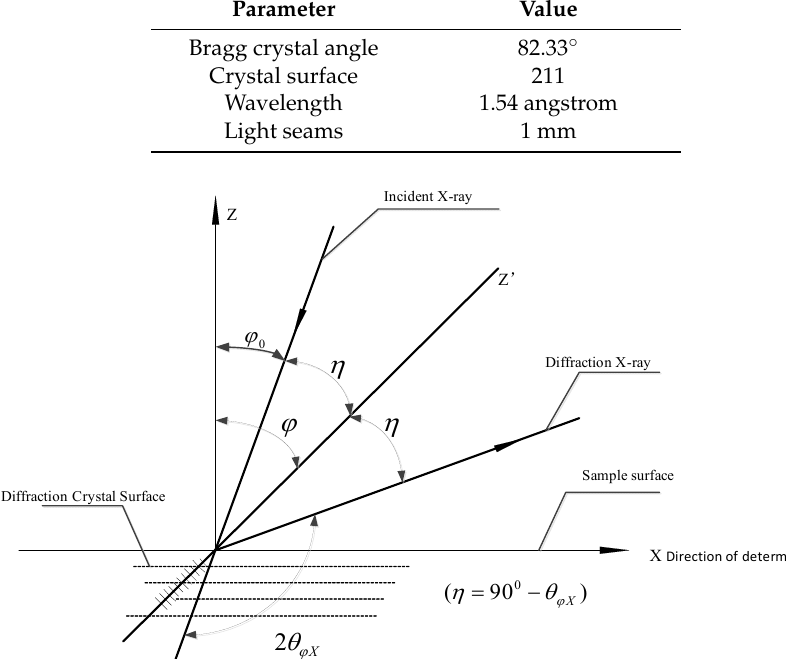
Figure 4. Schematic diagram of residual stress measurement.